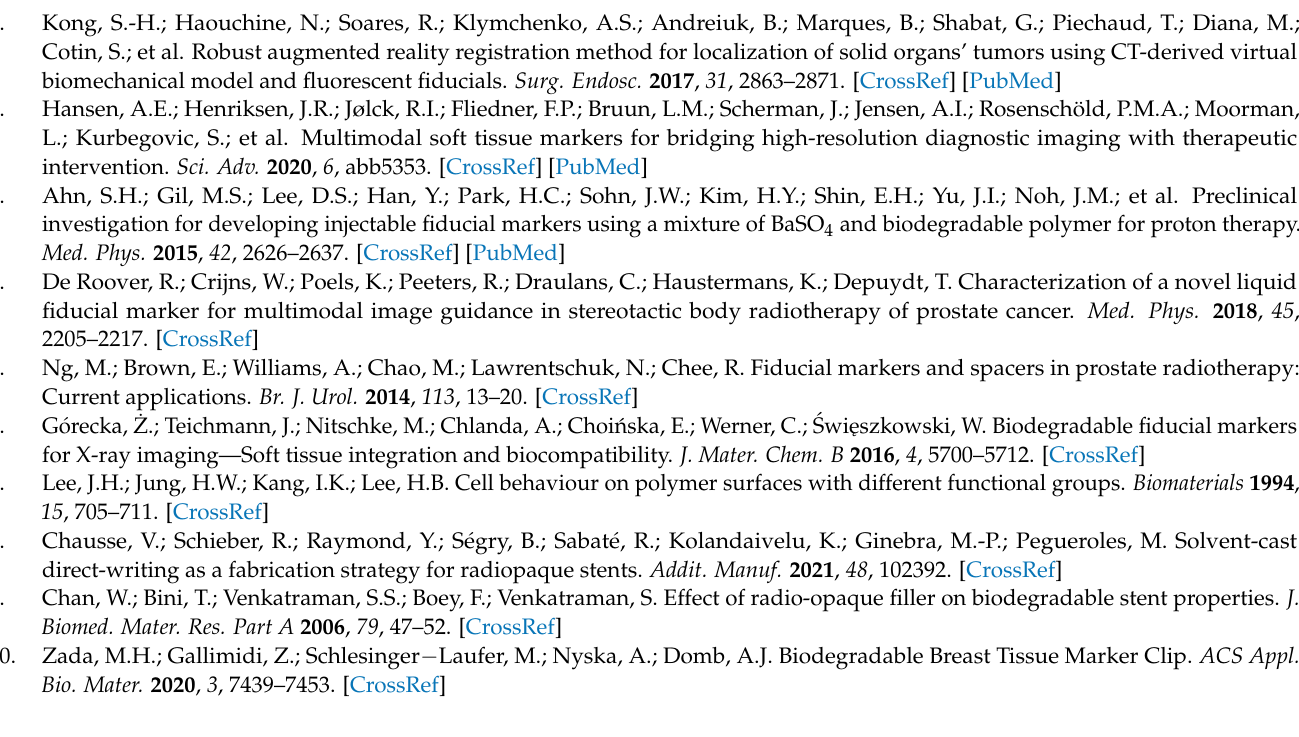
Figure S1: The HU value calculated from 8-bit images of reconstructed cross-sections of MicroCT- scanned samples; Figure S2: The DSC thermograms (second heating run): (a) PCL-, (b) PLC70-, (c) PLC85-, and (d) PLG82-based materials in the form of P—raw polymer, C—solvent cast composite plate, R—thermally extruded rods; Figure S3: The SEM image of 3D-printed PCL-1010-BH structure with G32 nozzle (ID 0.1 mm); Figure S4: Thermograms of investigated composite materials within degradation experiment; Figure S5: The characteristic temperatures and enthalpies appointed from second heating run of DSC; Section S2: Detailed DSC analysis; Section S3: FTIR analysis of filler– polymer interactions; Figure S6: The FTIR spectra of: the upper part of the image—solvent cast composite plates (PCL-1010-BH-C (1-yellow), PLC70-1010-BH-C (2-blue) and PLG82-1010-BH-C (3-green)); Figure S7: The FTIR spectra of HAp and BaSO 4 powders after stirring in CHCl3, PLC70 casted film, and HAp and BaSO 4 obtained after dissolution of PLC70-based composites containing only one filler; References [64–67] are cited in the supplementary